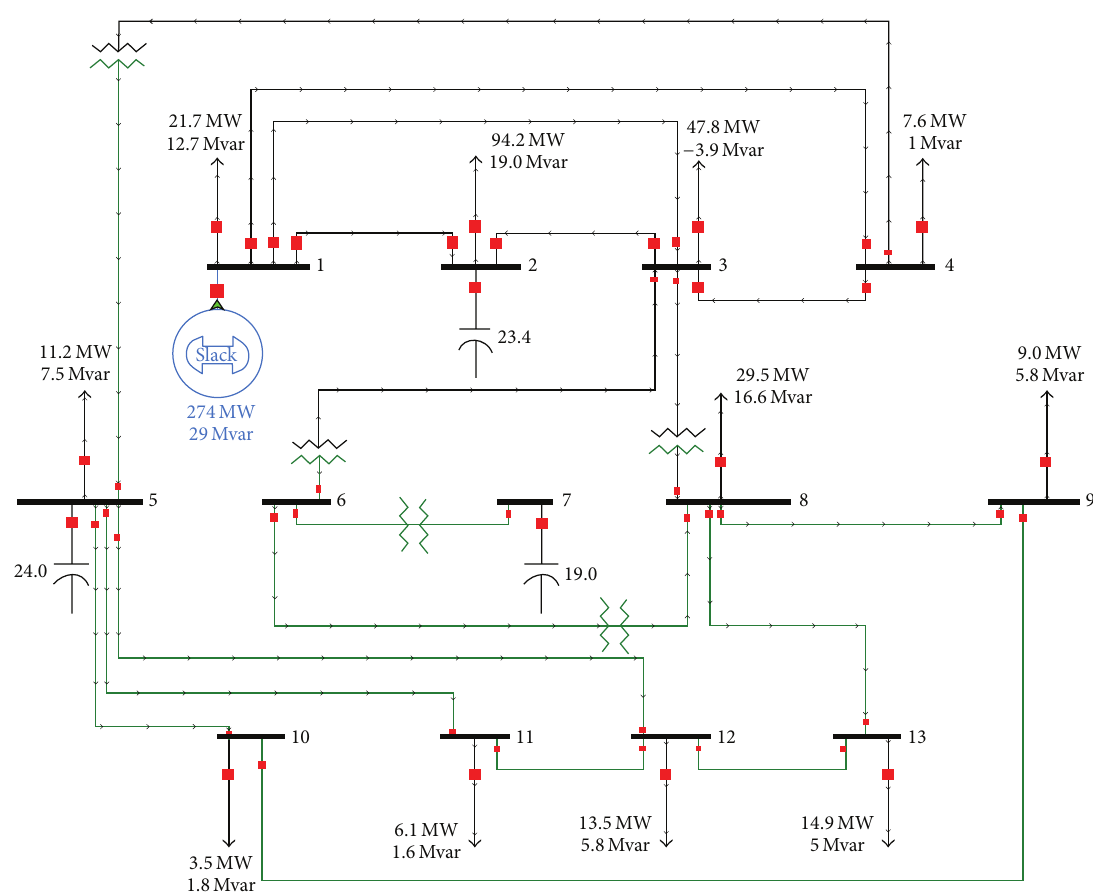
Figure 5: The 13- bus system for